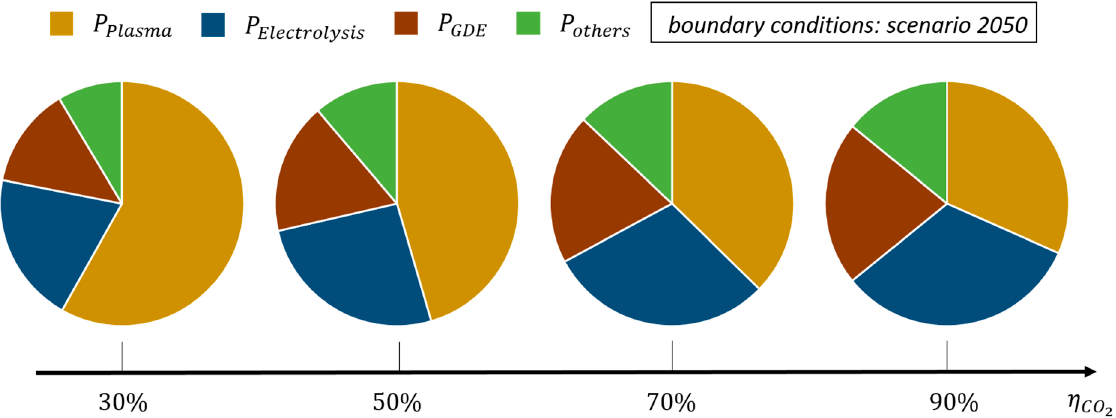
Figure 12. Development of power distribution by increasing the energy efficiency of the plasma-based CO 2 splitting (300 MW total).